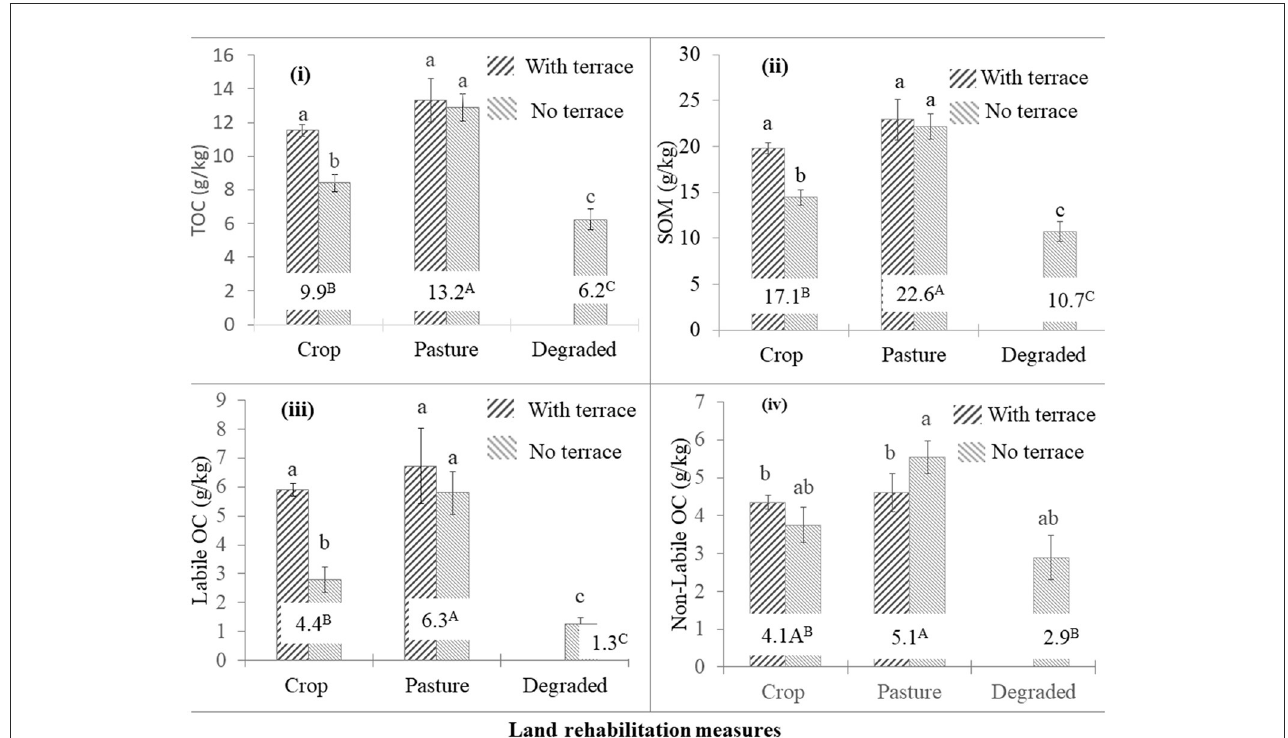
FIGURE4 Influence of rehabilitation measures on soil total organic carbon (i) , organic matter (ii) , labile (iii) , and non-labile carbon fractions (iv) . Different lower case letters indicate significant difference within the same type of land use between the terraced and un-terraced systems at p = 0.05. Different upper case letters indicate significant difference across different land uses at p =